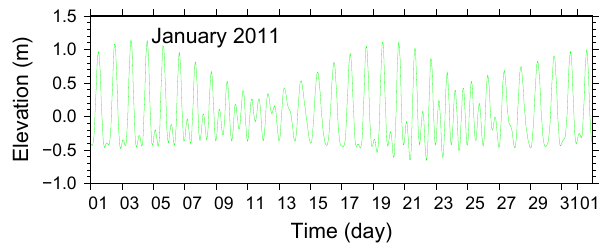
Figure 10. Modelled tides for January 2011 where semi-diurnal, diurnal and fortnightly tidal periods are observable.